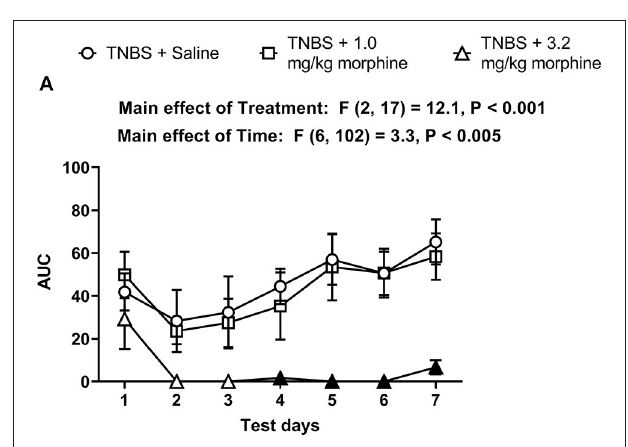
FIGURE 9 | Time dependent effect of repeated morphine treatment on TNBS-induced depression of nesting. (A) The area under the curve (AUC) of nesting scores recorded daily in mice treated with TNBS and saline, 1.0 or 3.2 mg/kg/day morphine s.c. Filled points represent statistical significance ( P < 0.05) vs. saline indicated by a main effect of treatment by repeated measures two-way ANOVA with Bonferroni’s test. Data are mean ± SEM. Sample sizes for the experimental groups are as follows: TNBS + saline ( N = 8/day); TNBS + 1.0 mg/kg morphine ( N = 6/day); TNBS + 3.2 mg/kg morphine ( N = 6/day).